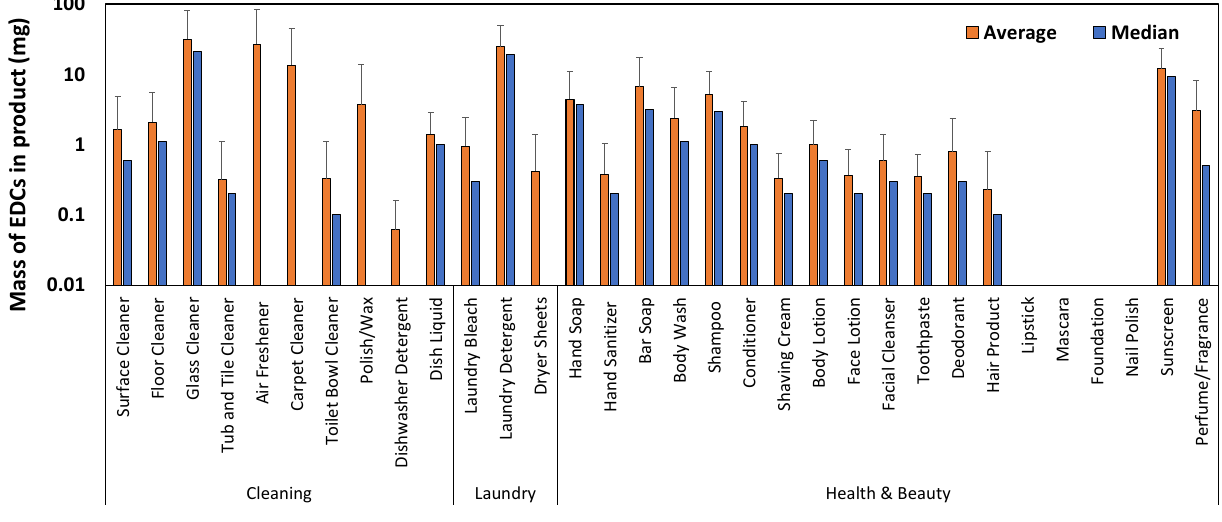
Figure 6. Average and median masses (mg) of EDCs calculated to be in each product for the 39 participating citizen scientists. Error bars represent the standard deviations.